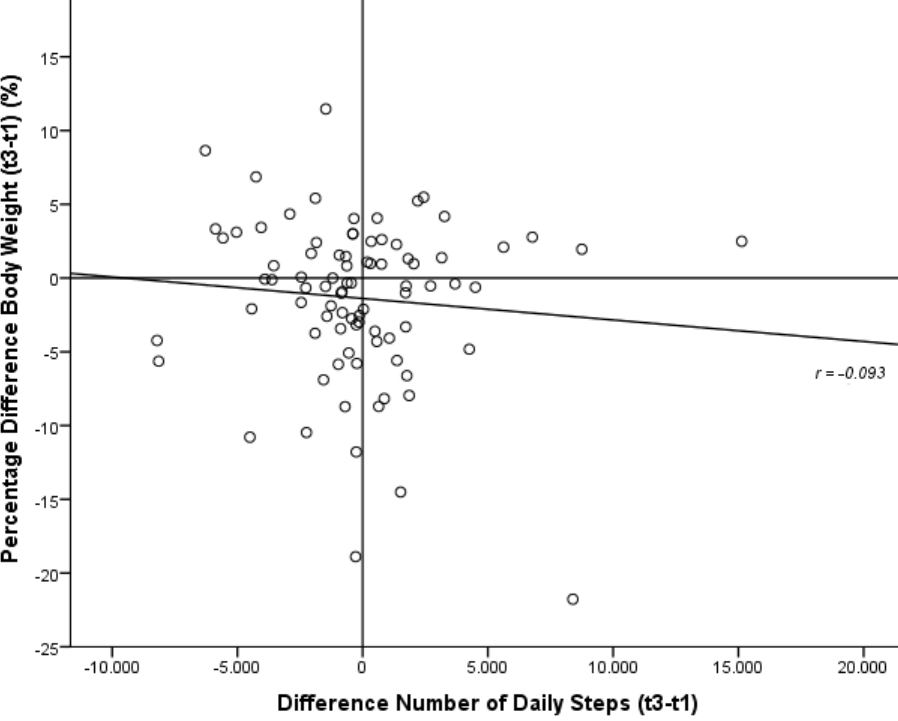
Figure 2. Correlation of differences of the percentage body weight with the difference of number of daily steps between baseline (t1) and six-month follow-up